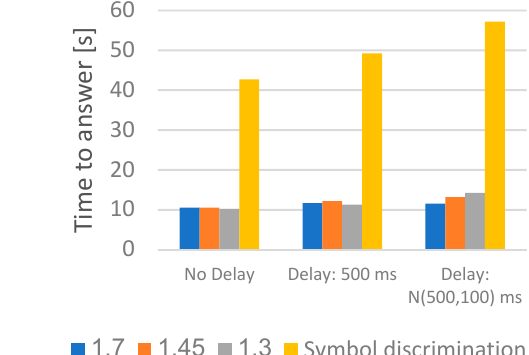
Figure 5. Average hit rate and time to answer in the relative width measurement and symbol identification tests.